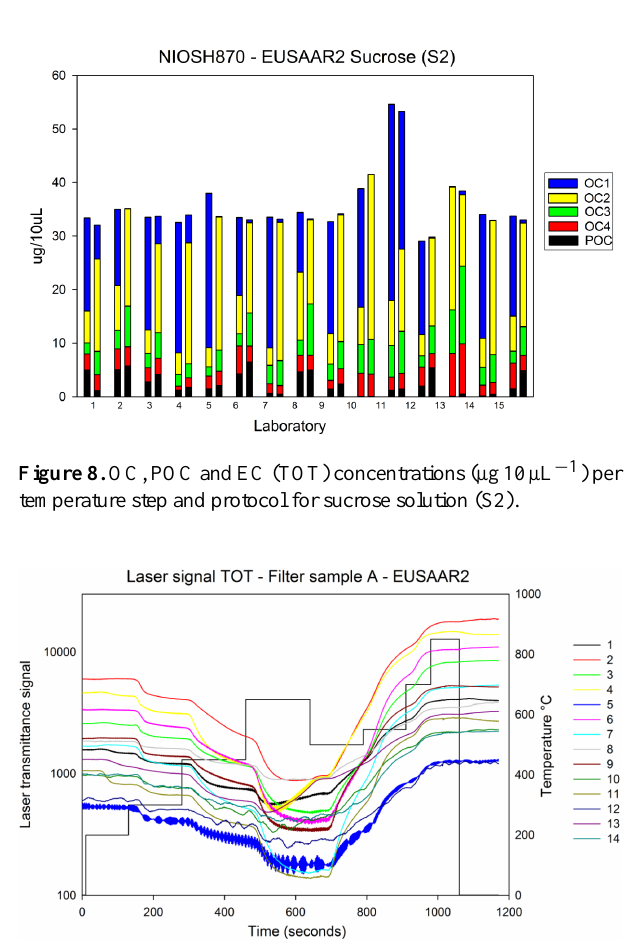
Figure 9. Laser transmittance signal during filter sample A analysis with the use of EUSAAR2 thermal protocol for all laboratories.